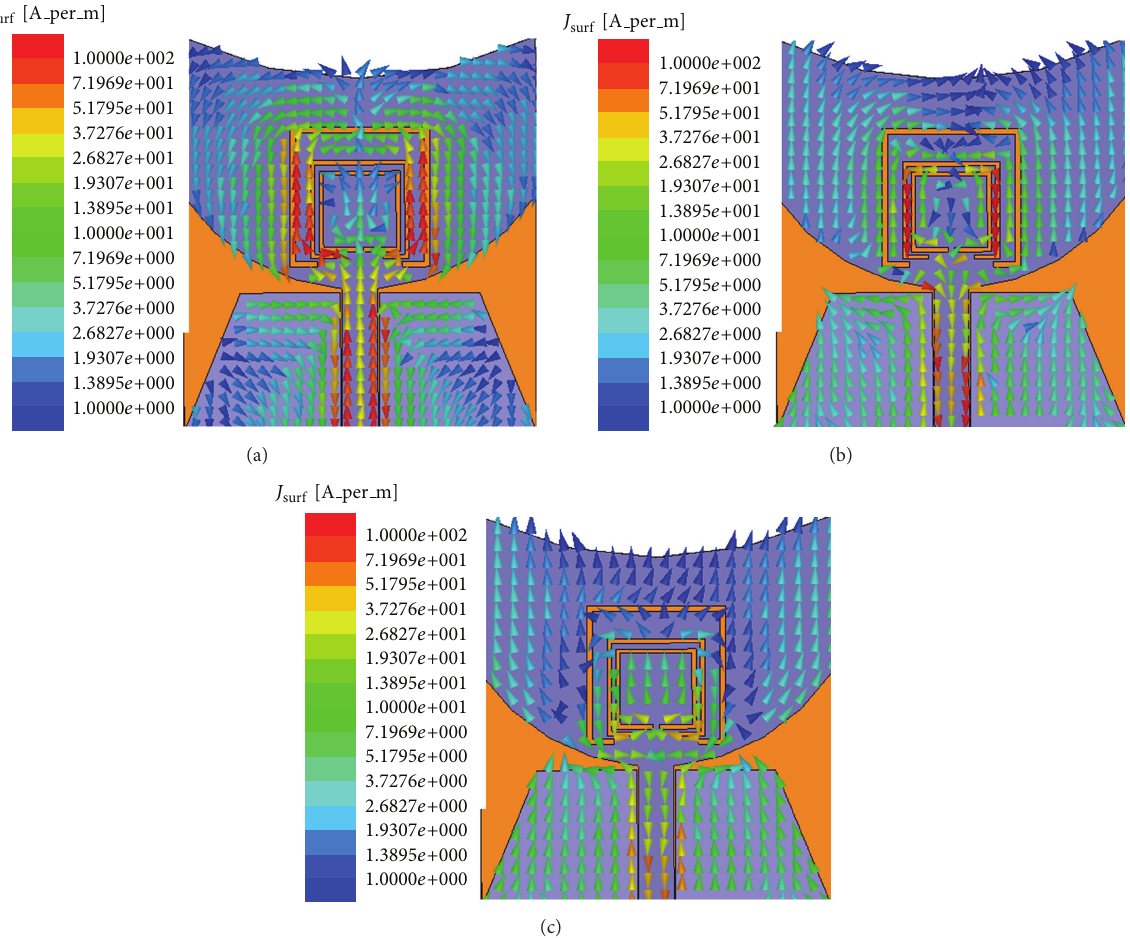
Figure 2: The current distribution at different frequencies (a) 3.9 GHz, (b) 5.2 GHz, and (c) 5.9 GHz.